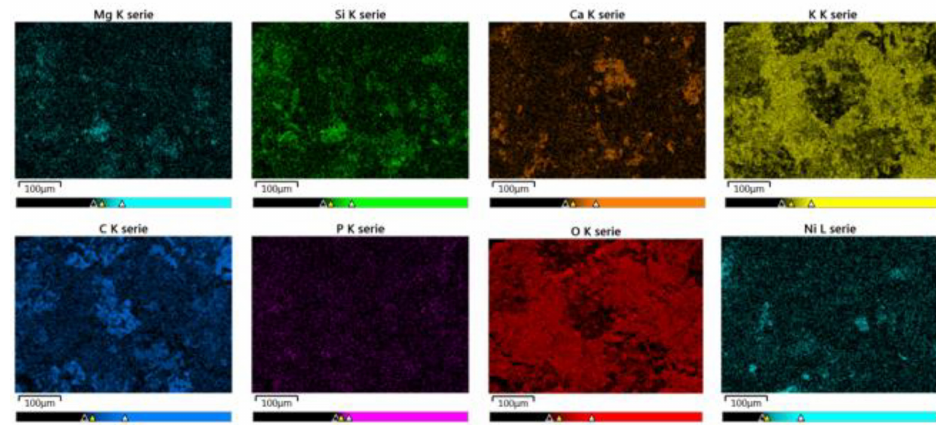
Figure 15. EDX analysis of solid deposits from experiment